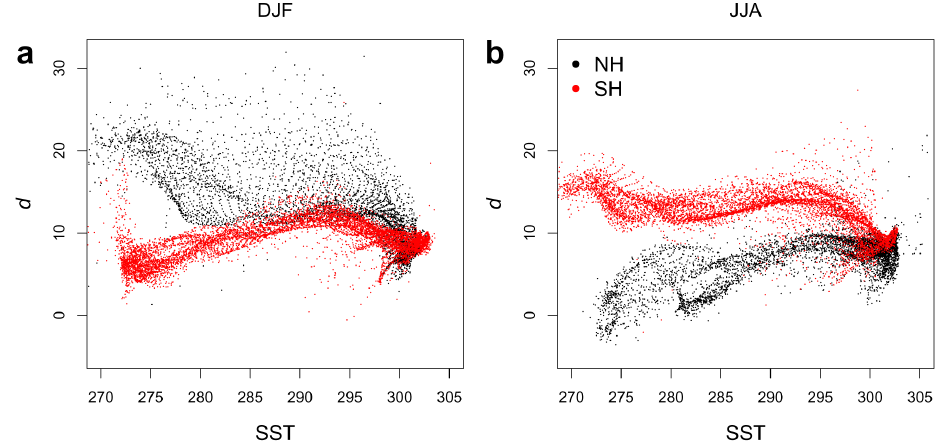
Fig. 6. Seasonal means of d as obtained from our model plotted against seasonal mean SST from the corresponding ERA-Interim grid boxes for (a) DJF and (b) JJA. For clarity, only every third point is